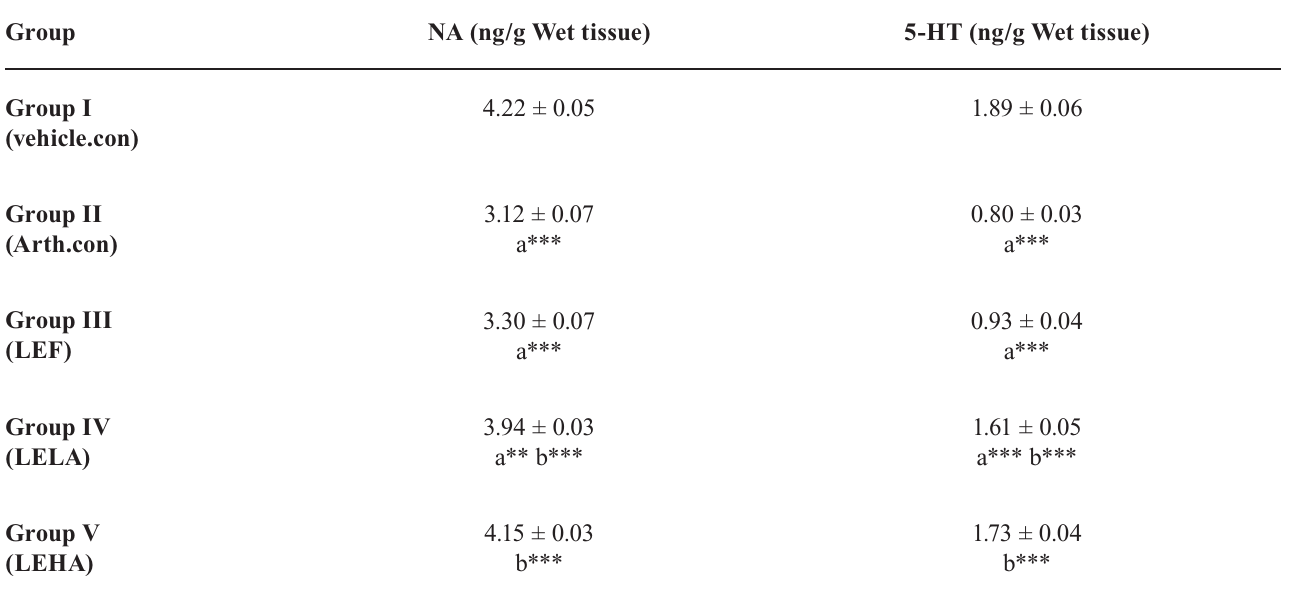
TABLE XIII- Effect of leflunomide and amitriptyline on Brain neurotransmitters in FCA induced arthritic